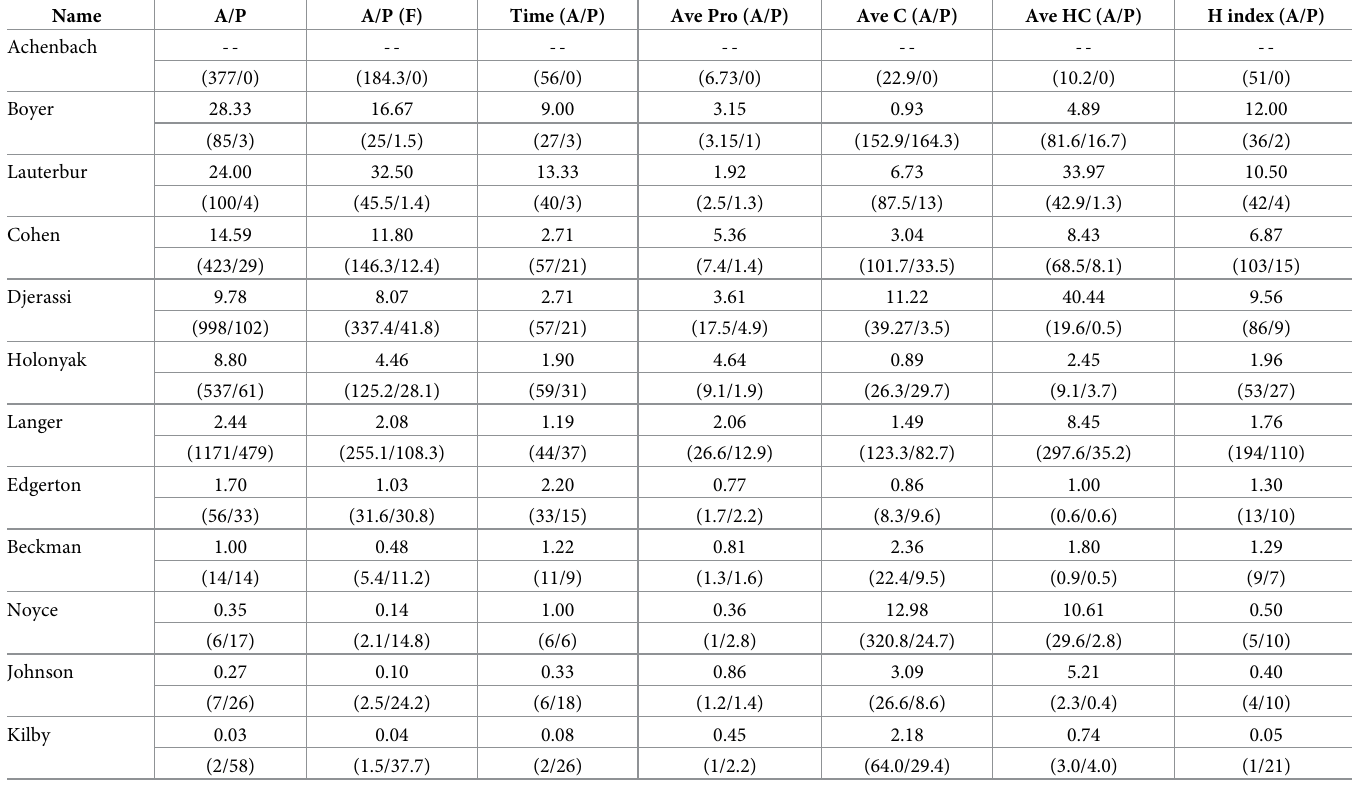
Table 3. Ratios of articles to